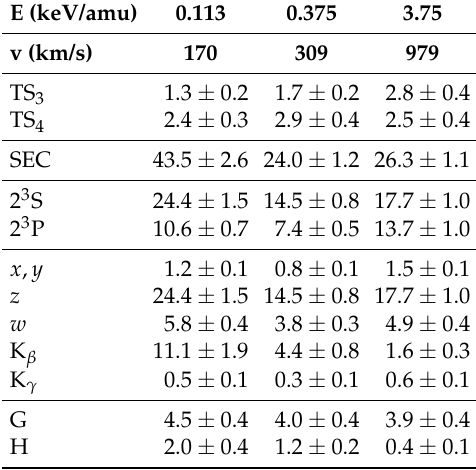
Table 2. From the measured EUV line-emission cross-section for collisions of C 5 + on H 2 O the following quantities are derived: triplet-to-singlet ratios (TS 3 TS 4 ), total cross-section for pure one-electron transfer (SEC), cross-sections for cascade population of 2 3 S and 2 3 P and for K-series line emission and finally the diagnostic ratios G and H. All cross-sections are in units of 10 − 16 cm 2 . E (keV/amu)